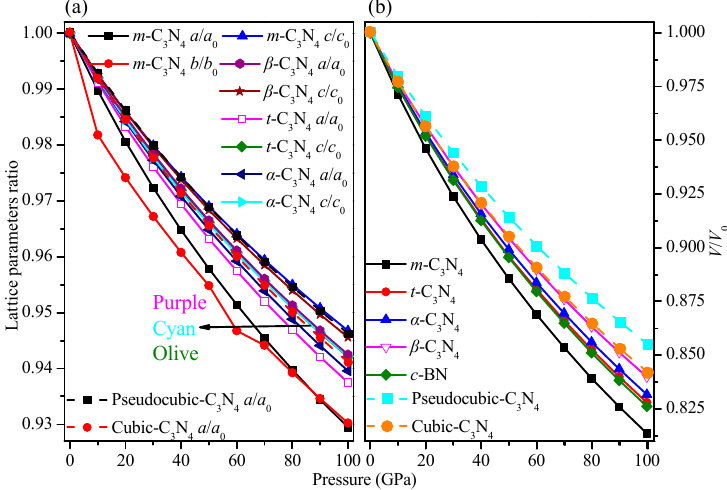
Figure 2. The lattice constants a / a 0 , b / b 0 , c / c 0 and V / V 0 of compression as functions of pressure and temperature for: m -C 3 N 4 ( a ); and t -C 3 N 4 ( b ).